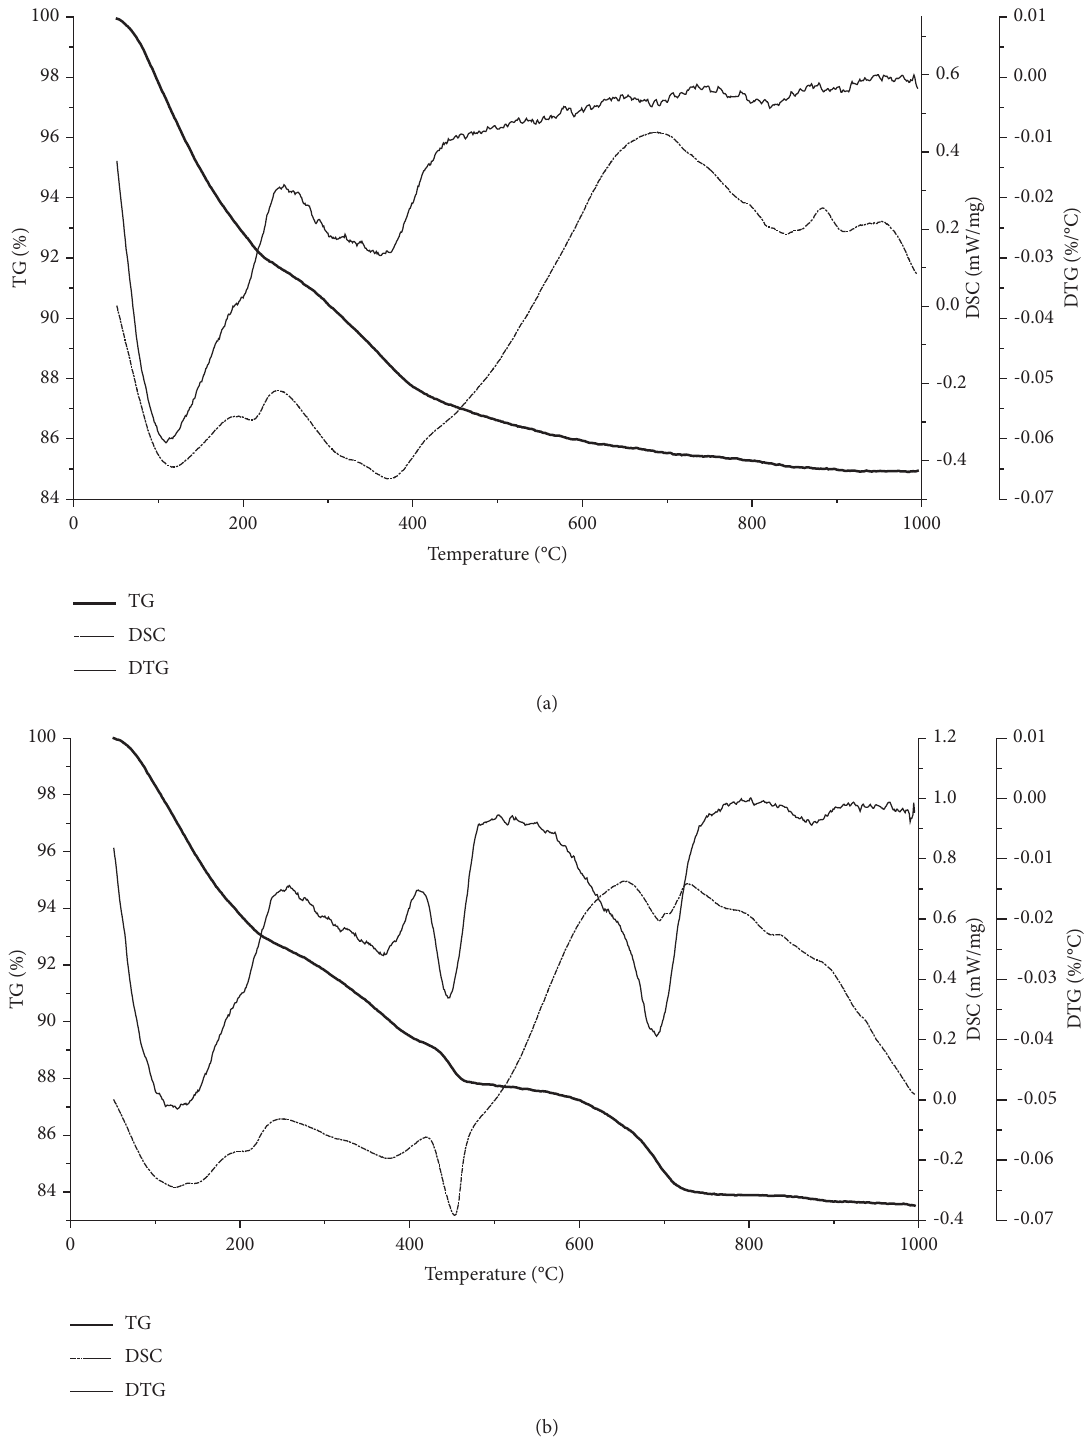
Figure 4: TG-DSC-DTG plots of C0 and C12 at 56d; (a) TG-DSC-DTG plots of C0 at 56d; (b) TG-DSC-DTG plots of C12 at